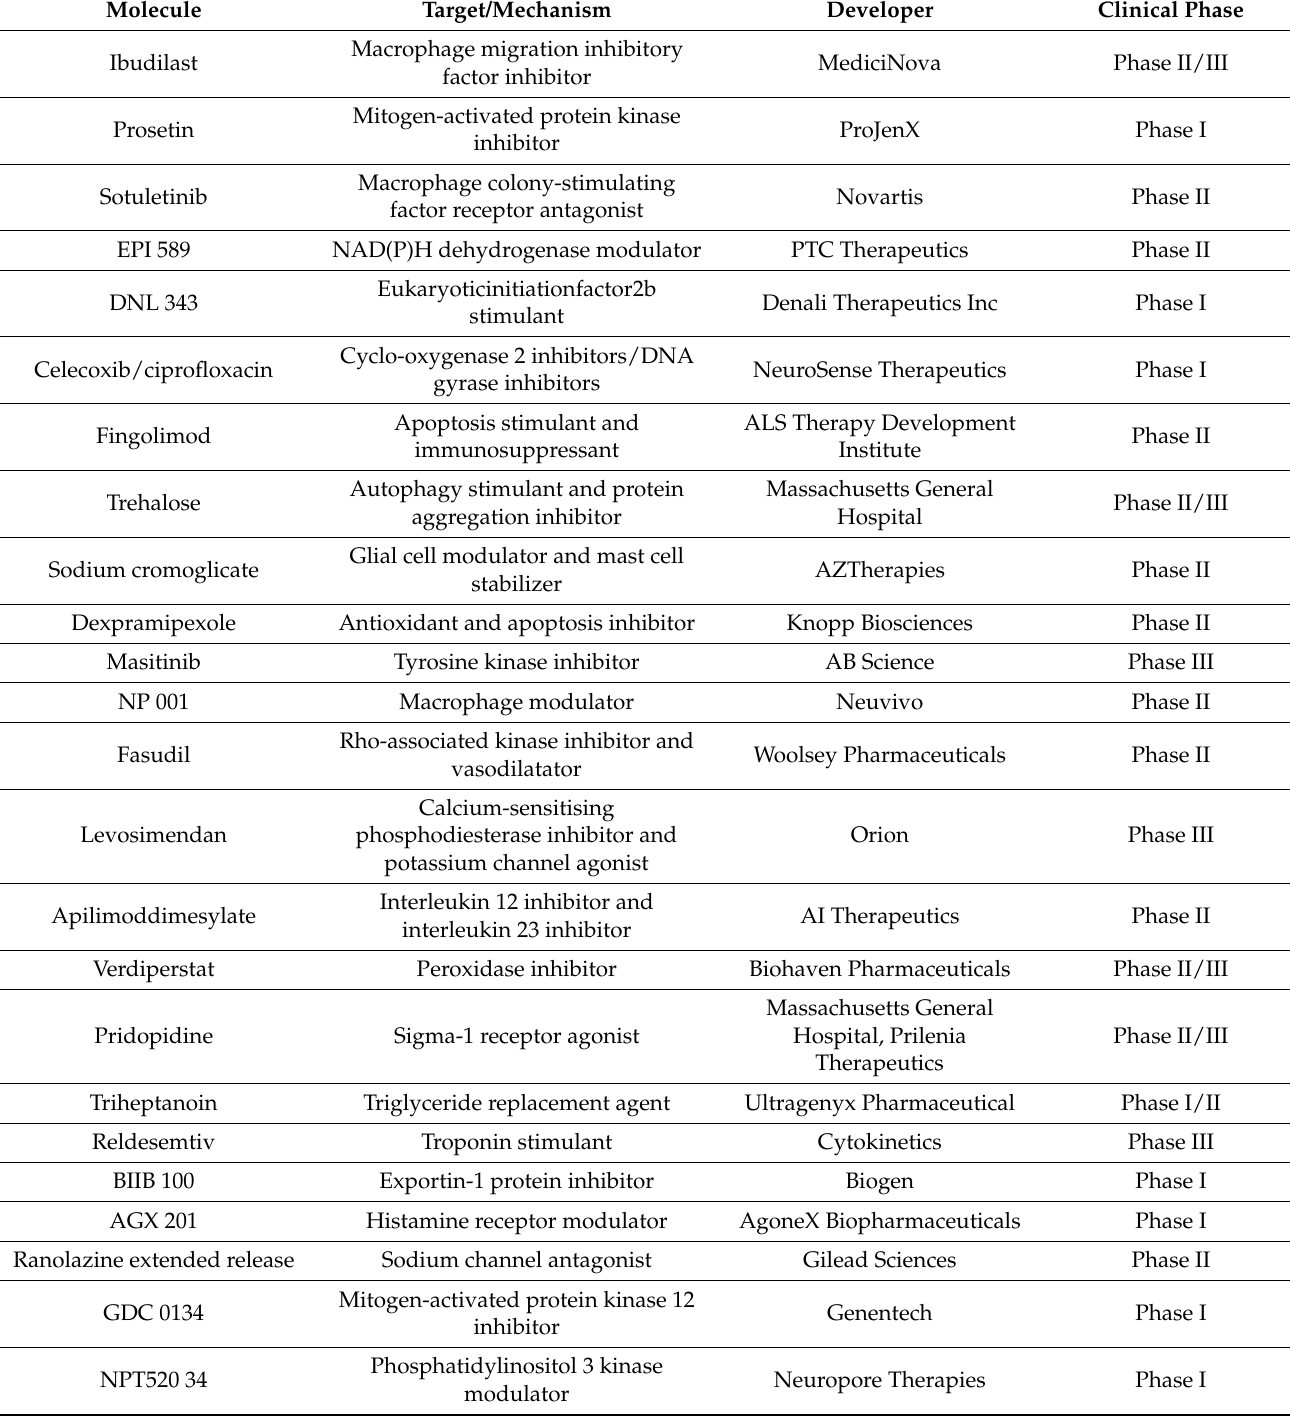
Table 1. Table reporting the different smallmolecules currentlyin FDA clinical trials for ALS treatment (updated 13 April